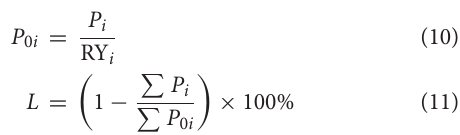
Frontiers in Sustainable Food Systems |